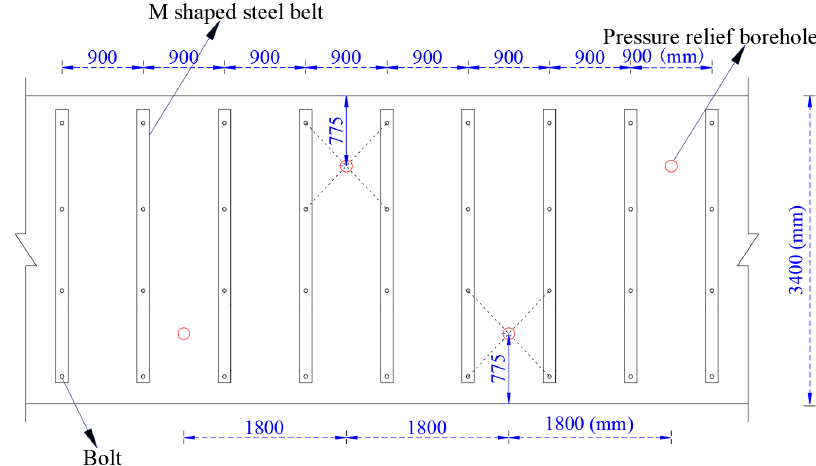
Figure 10. Pressure relief drilling parameters of solid coal side.